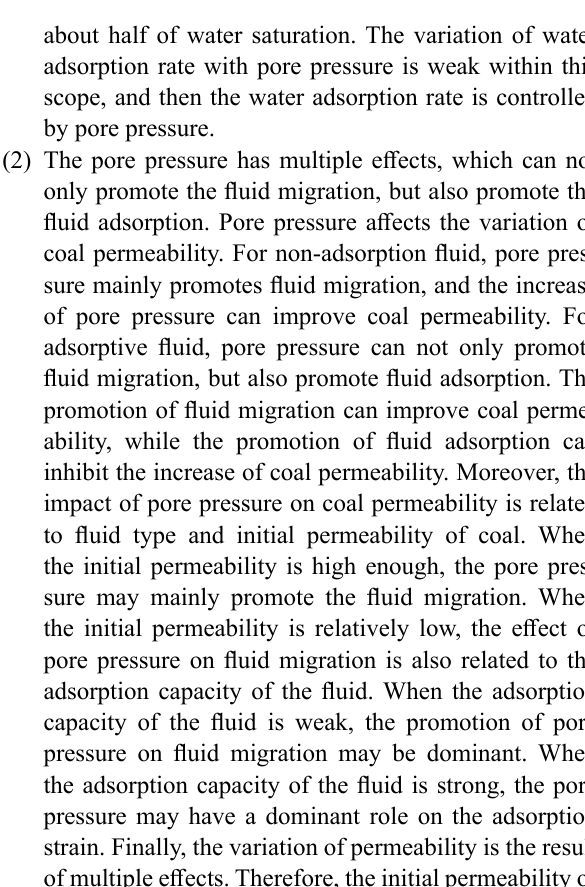
Fig. 12 Influence of initial permeability and fluid adsorption capacity on coal permeability. a Relatively high permeability; b Relatively low per- meability; c and e Weakly adsorbed fluid; d and f Strongly adsorbed fluid. Note: P is pore